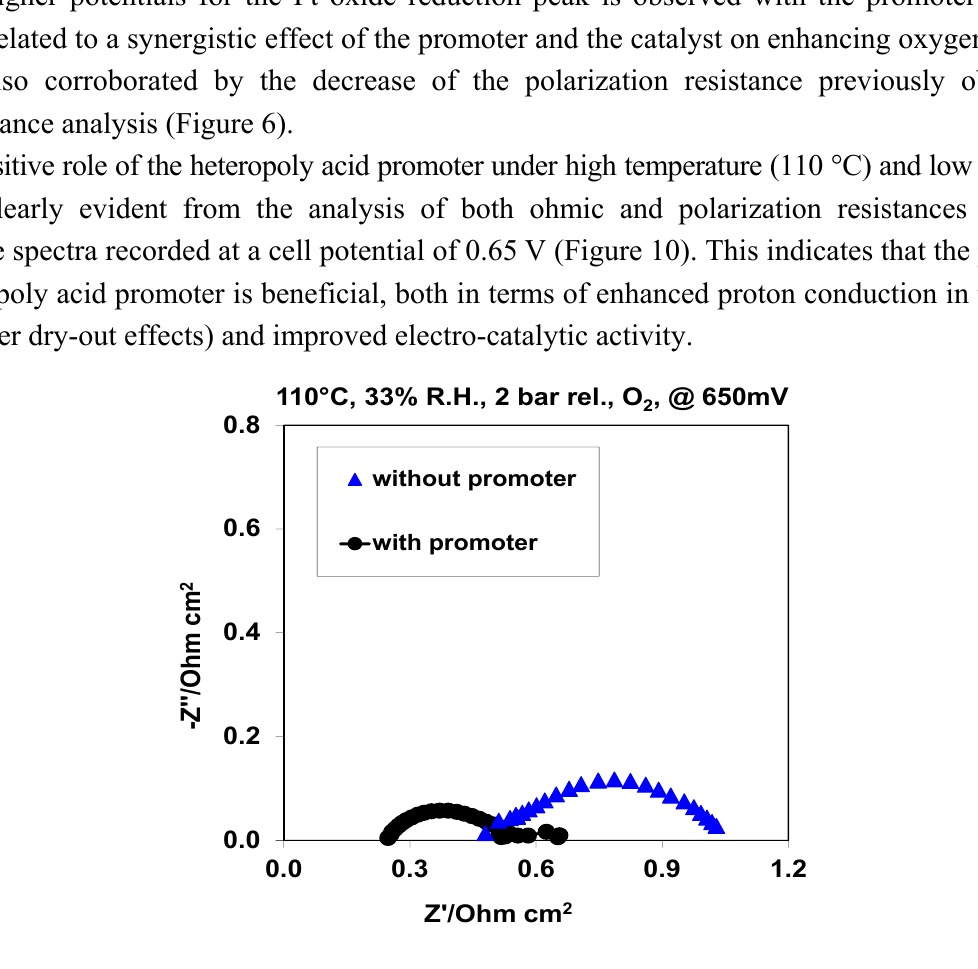
Figure 10. AC impedance spectra at 110 °C, 33% R.H., 0.65 V, for the PtCo-based catalytic layer with and without